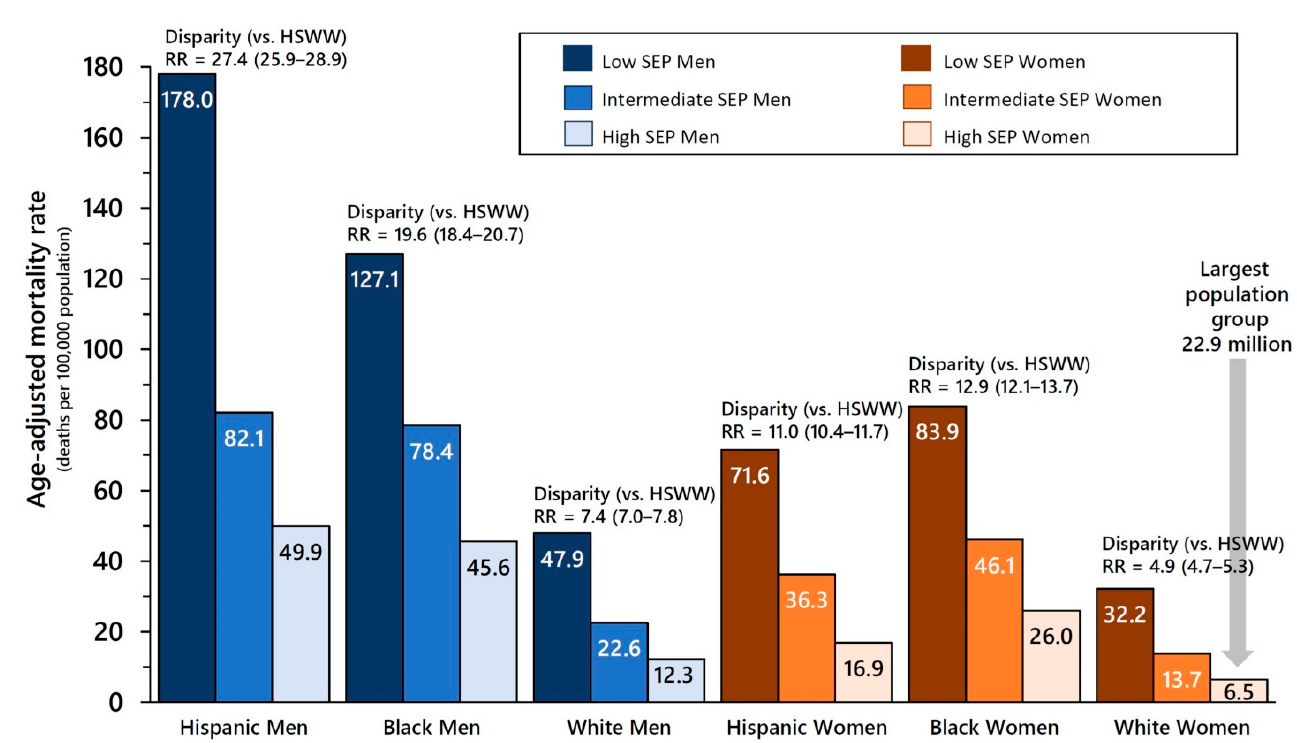
Figure 3. COVID-19 Death Rates by Socioeconomic Position (SEP), Gender, and Race/Ethnicity with High-SEP White Women (HSWW) as the Referent Group for Disparity Rate Ratios ** among Adults 25–64 Years Old, United States 1 January 2020 to 31 December 2020. Note : ** The disparity rate ratios (RR) are calculated separately for each sociodemographic group and compare age-adjusted COVID-19 death rates to the referent group (high-SEP white women (HSWW)). Results are presented for the three largest population groups (whites, Hispanics, and Blacks). All rate ratios and full results for Asians, Indigenous adults (American Indians, Alaska Natives, Native Hawaiians, and other Pacific Islanders) and multiracial adults are shown in Table S2.